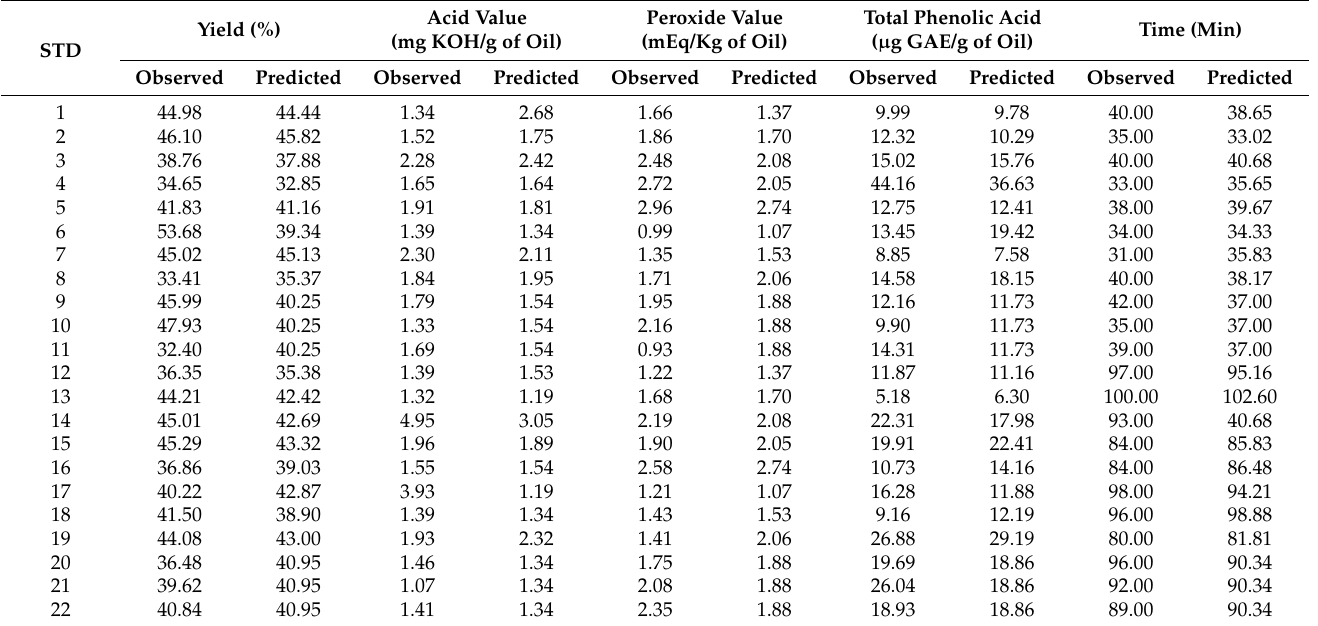
Table 2. The predicted and observed CSO yields, acid and peroxide values, total phenolic content, and pressing time.